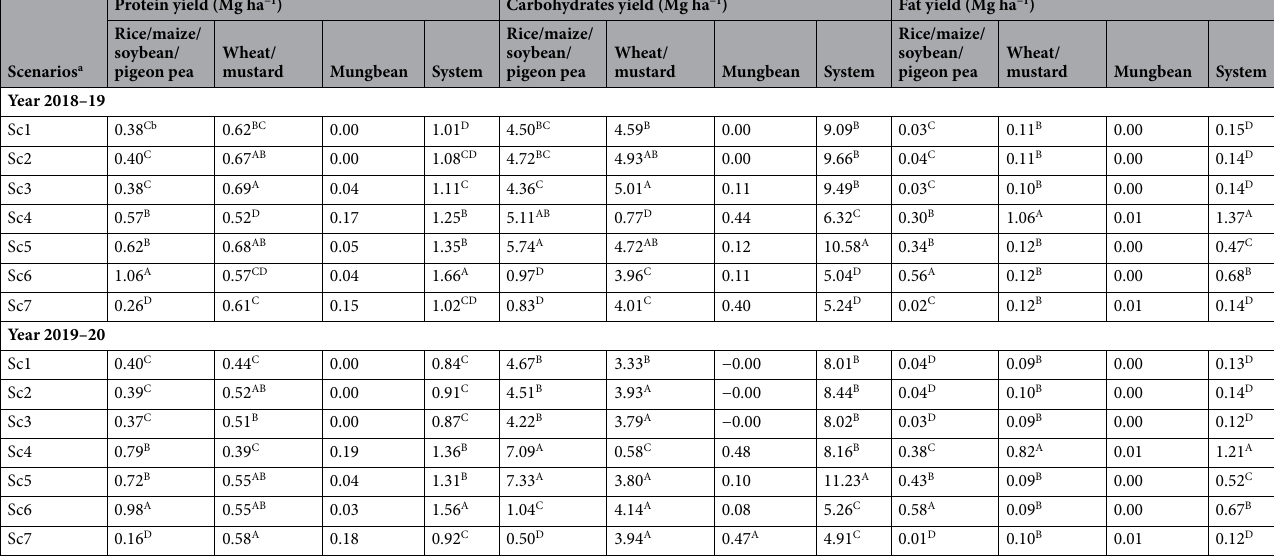
Table 2. Protein, carbohydrates and fat yield of different crops and cropping systems as affected by different management practices during the year 2018–19 and 2019–20. a Refer Table 4 for description of scenarios. b Means followed by a similar uppercase letter within a column are not significantly different at 0.05 level of probability using Tukey’s HSD test.